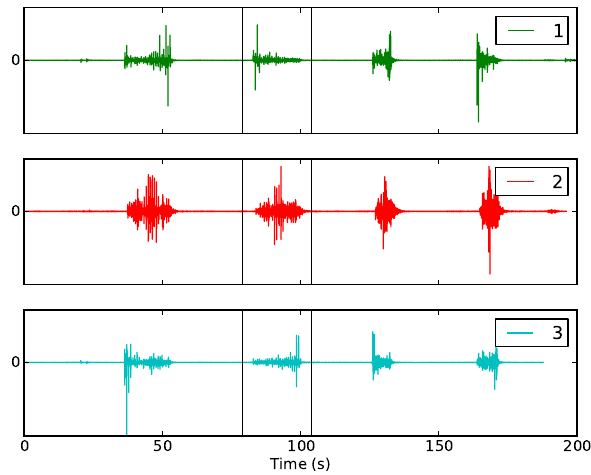
Figure 22. Spectogram of second bridge crossing. Fig. 22: Spectogram of second bridge crossing